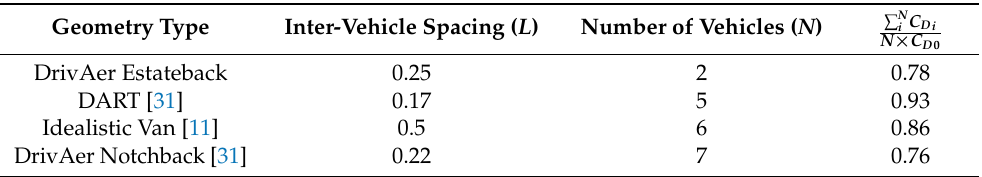
Table 4. Summary of potential drag savings of different geometries in a platoon of different sizes. C Di is the drag coefficient corresponding to the vehicle location within the platoon and C D 0 is the drag coefficient of the vehicle in